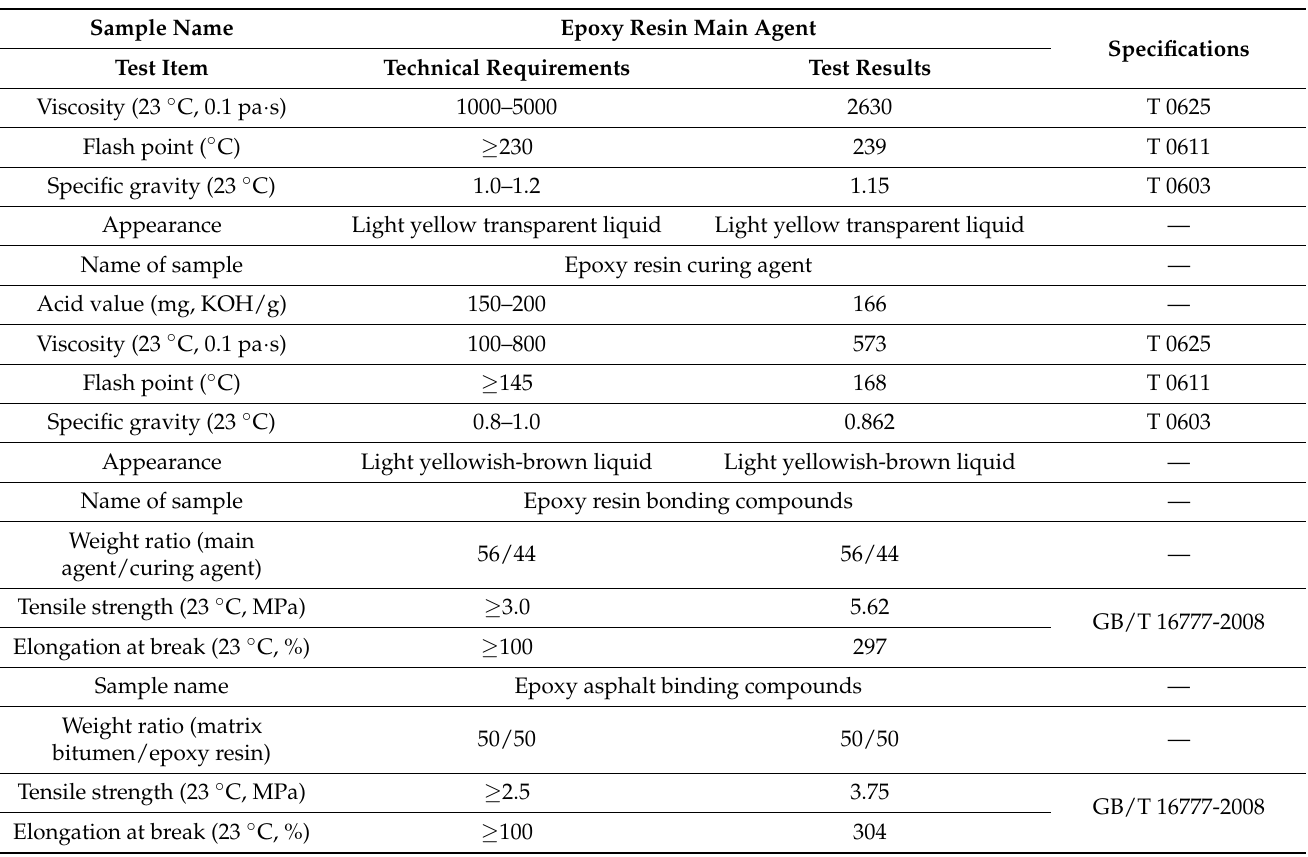
Table 6. Epoxy resin test